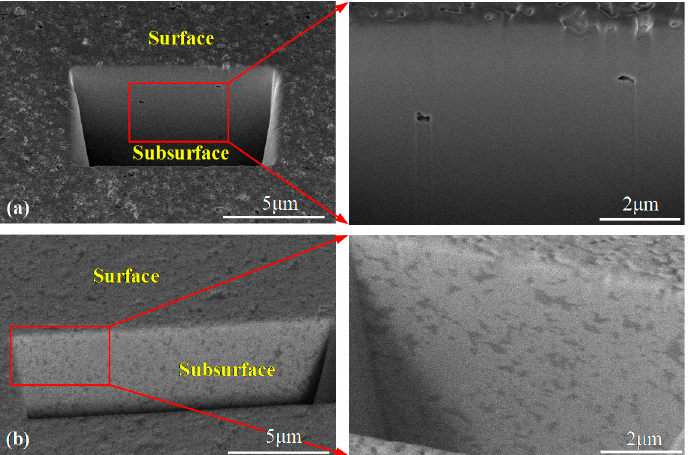
Figure 7. Subsurface SEM images of WC-0Co and WC-12Co after polishing, prepared with an FIB. ( a ) WC-0Co; ( b )